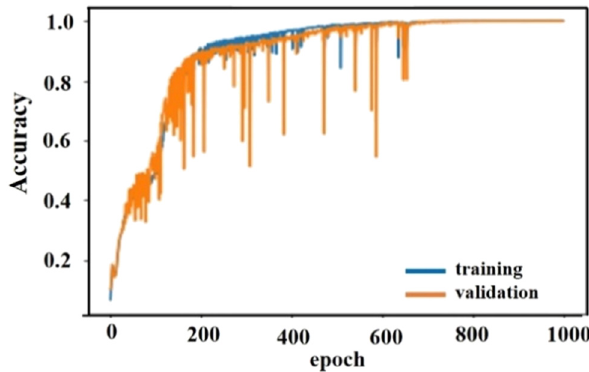
Figure 12: Model accuracy.